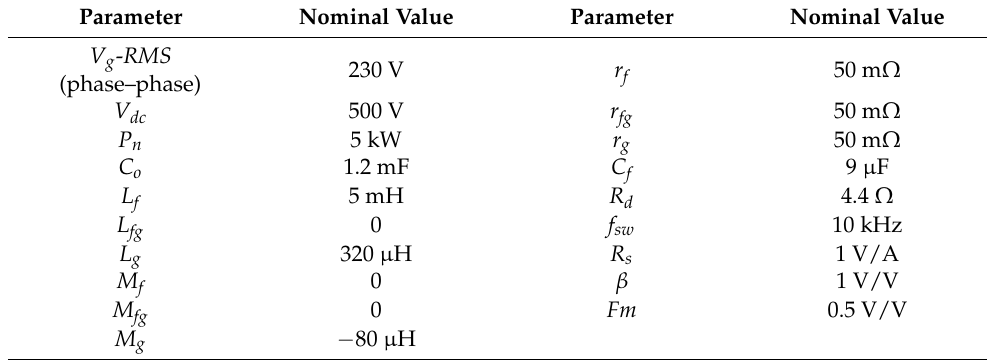
Table 4. Parameters of the inverters.